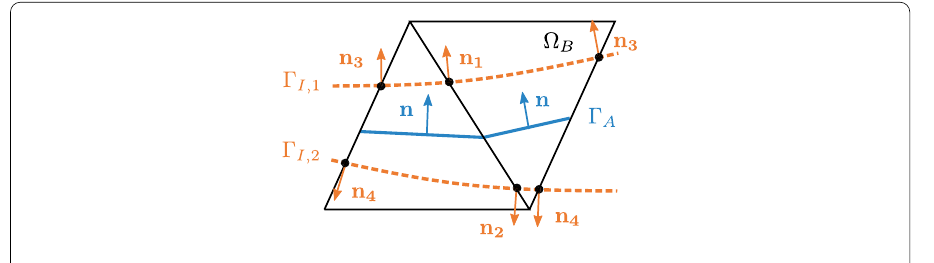
Fig. 20 Approximation of a properly aligned cutting plane for the case of multiple boundaries crossing single background elements